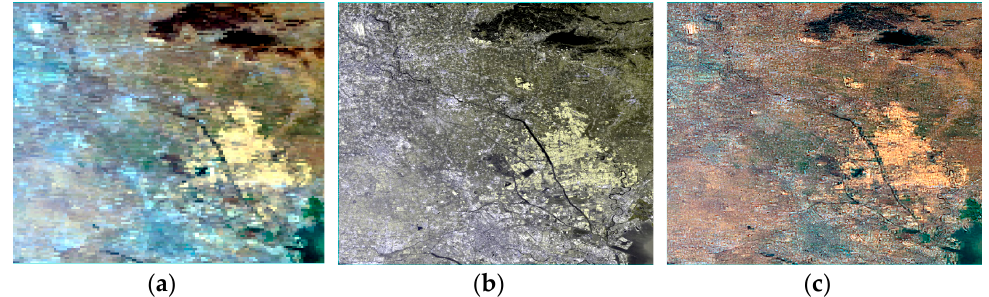
Figure 2. The downscaled result based on MI method: ( a ) is preprocessed 1 km MODIS image; ( b ) is 100 m GF-1 WFV image aggregated from a 16 m image; ( c ) is 100 m MODIS image based on MI method.